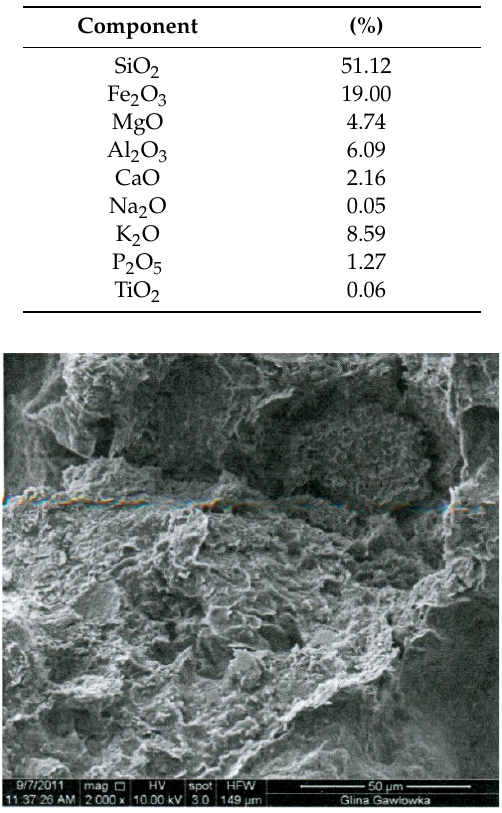
Figure 1. The microstructure of the examined clay [49].